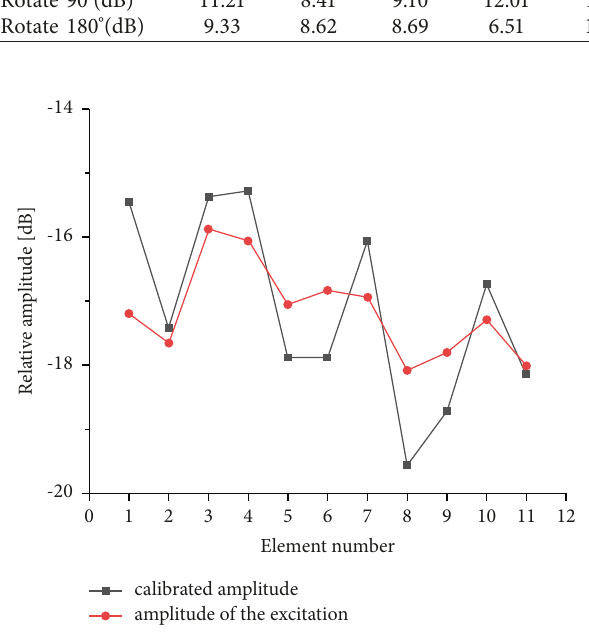
Figure 8: Relative amplitude comparison between calibrated result and excitation.